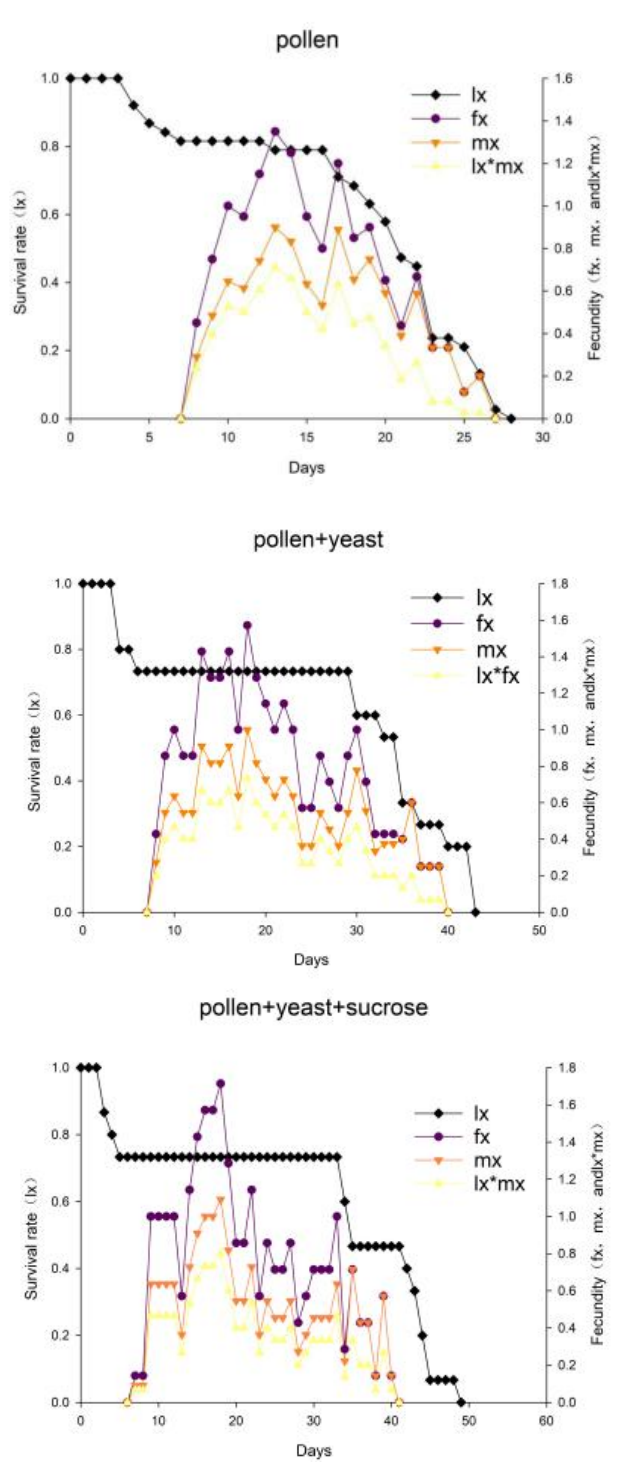
Figure 2. The population survival rate and fecundity of Amblyseius orientalis in the three treatment groups. l x indicates the probability that a new egg will survive to age x; f xj indicates the number of eggs laid by an adult female at age x and stage j; m x indicates the mean fecundity of individuals at age x; l x *m x indicates the product of l x and m x , age-stage specific reproduction. In all three treatment groups, the value of e xj decreased (Figure 3). For the pollen group, the pollen + yeast group, and the pollen + yeast + sucrose group, the maximum mean lifetime values were 19.05, 28.13, and 31.88 days, respectively.